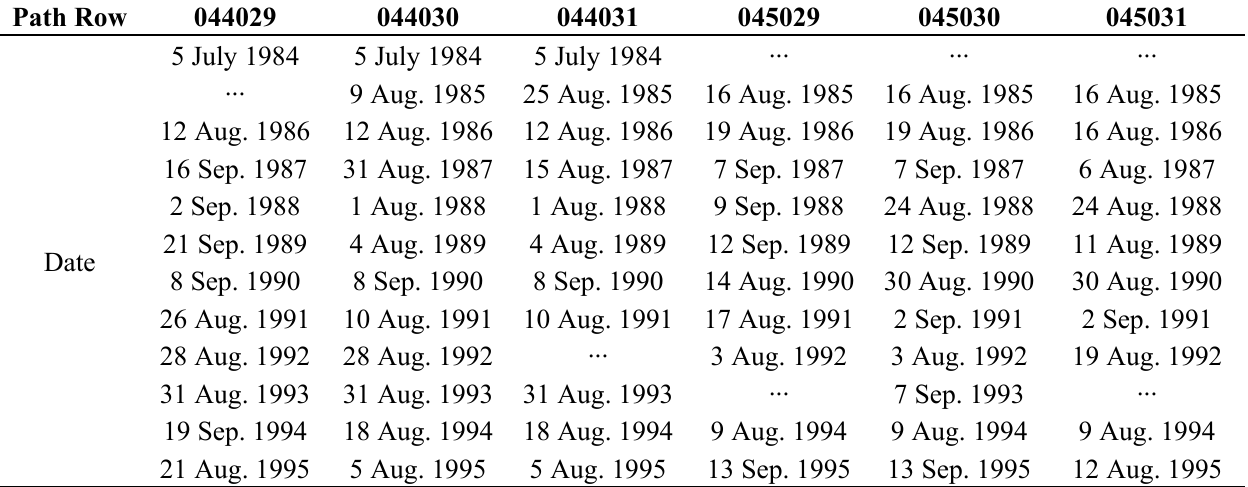
Table 1. Landsat 5 images used in